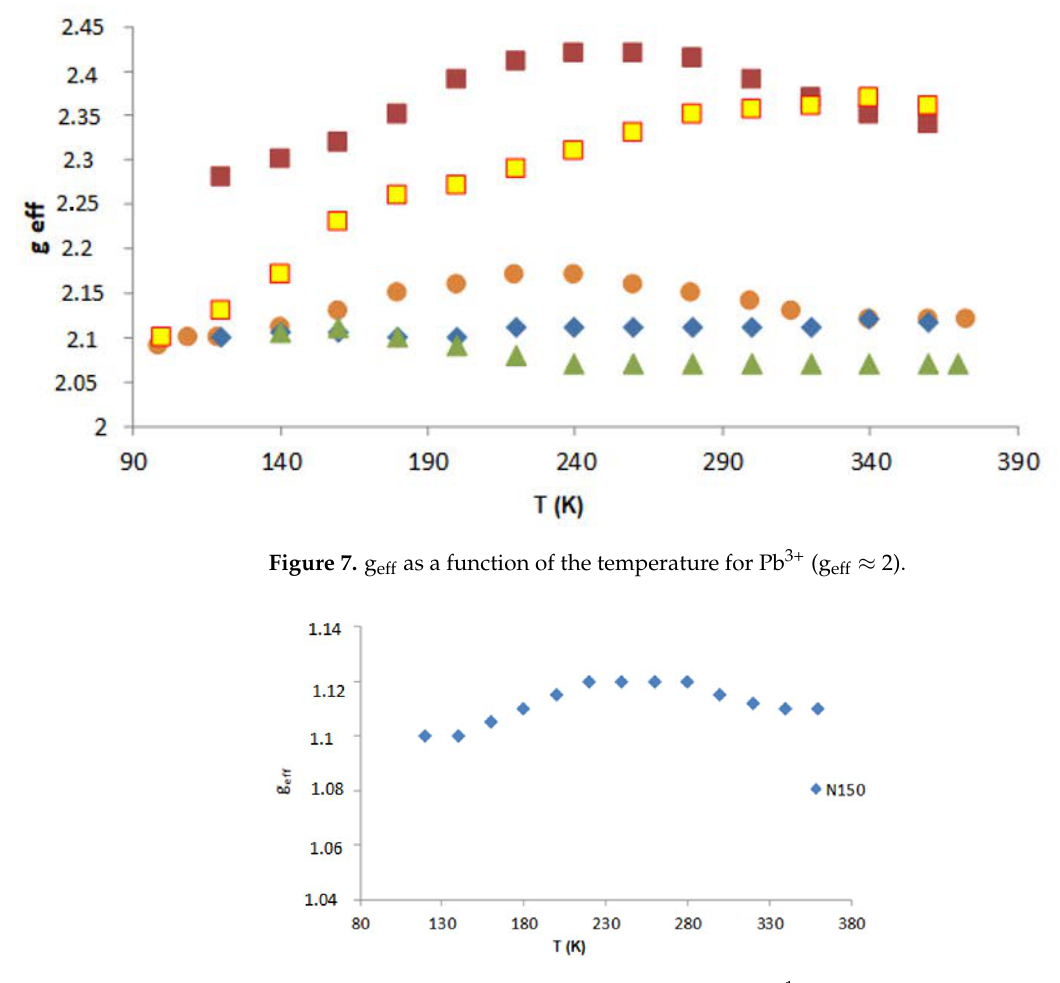
Figure 8. g eff as a function of the temperature for Pb 1+ (g eff ≈